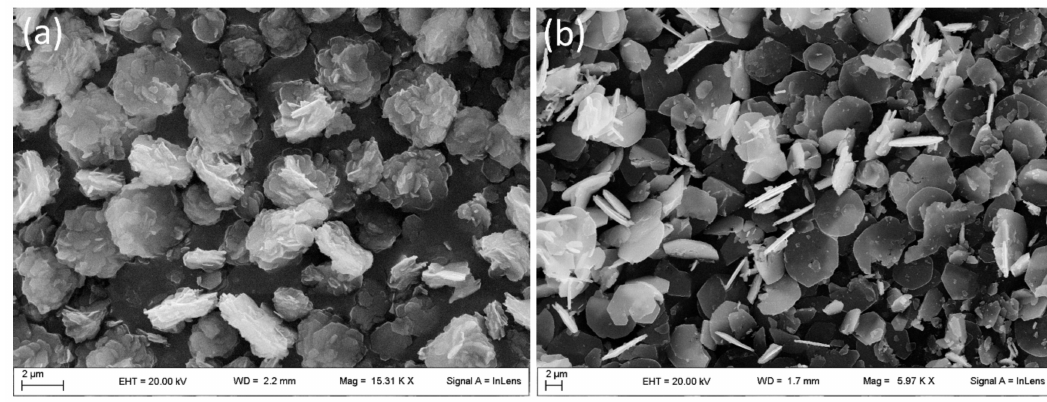
Figure 1. FE-SEM images of ZnAlCO 3 ( a ) and ZnAlCl ( b